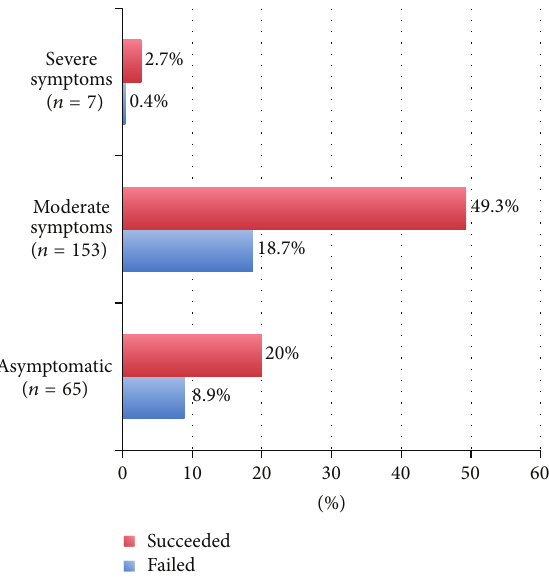
Figure 3: Symptomatology and failure of medical treatment.